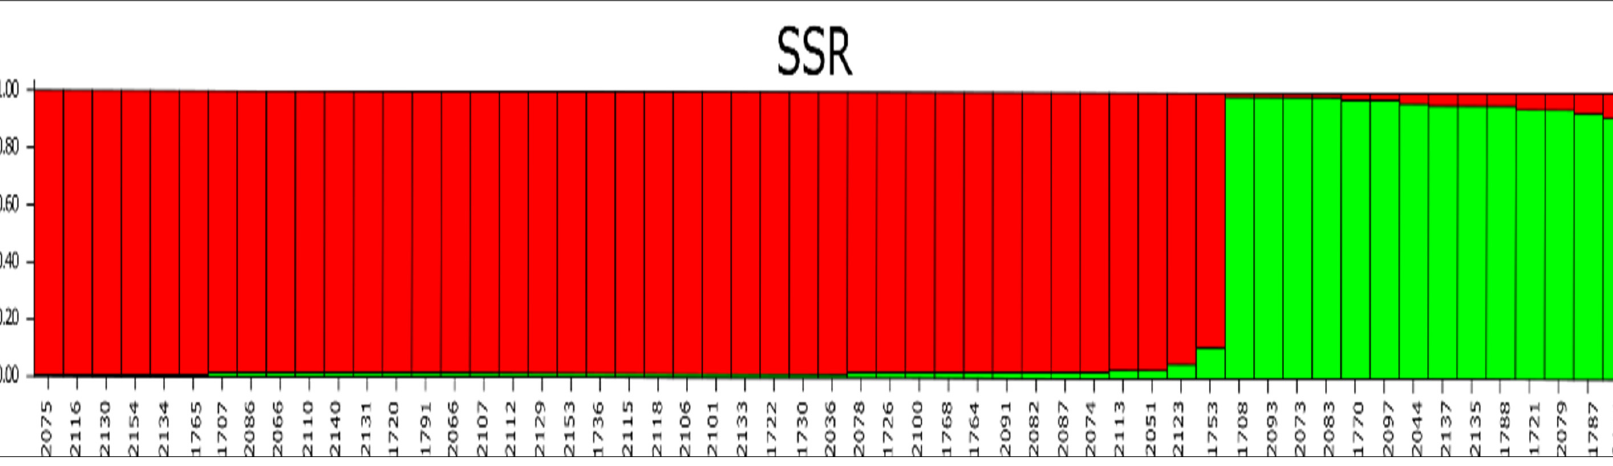
Figure 3. Genetic structure estimate for C. chinense accessions by Simple Sequence Repeat (SSR) primers. Group I is indicated by the color red and group II is indicated by the color green.